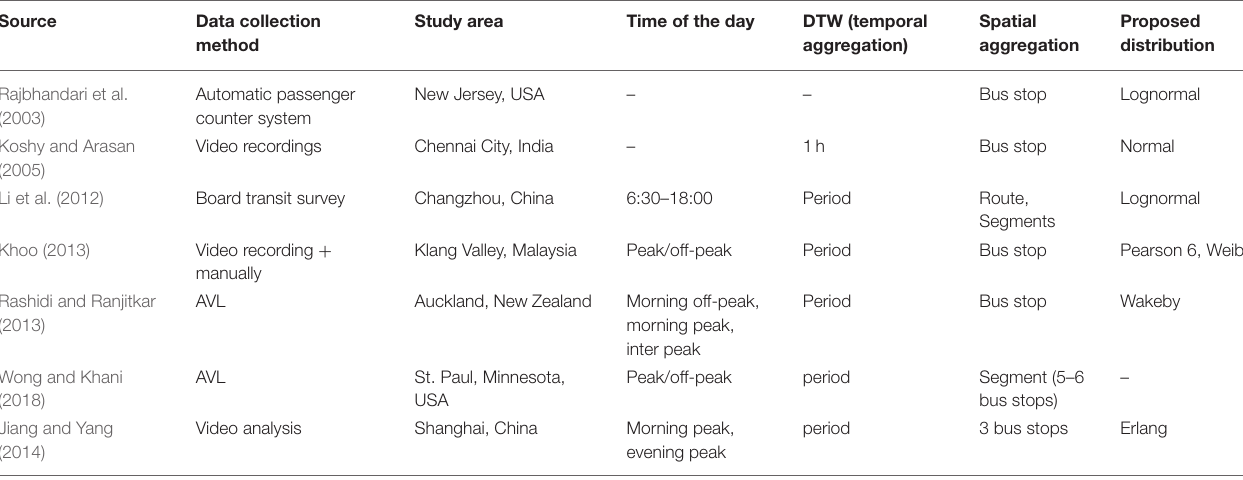
TABLE 3 | Compilation of studies examining dwell times. Source